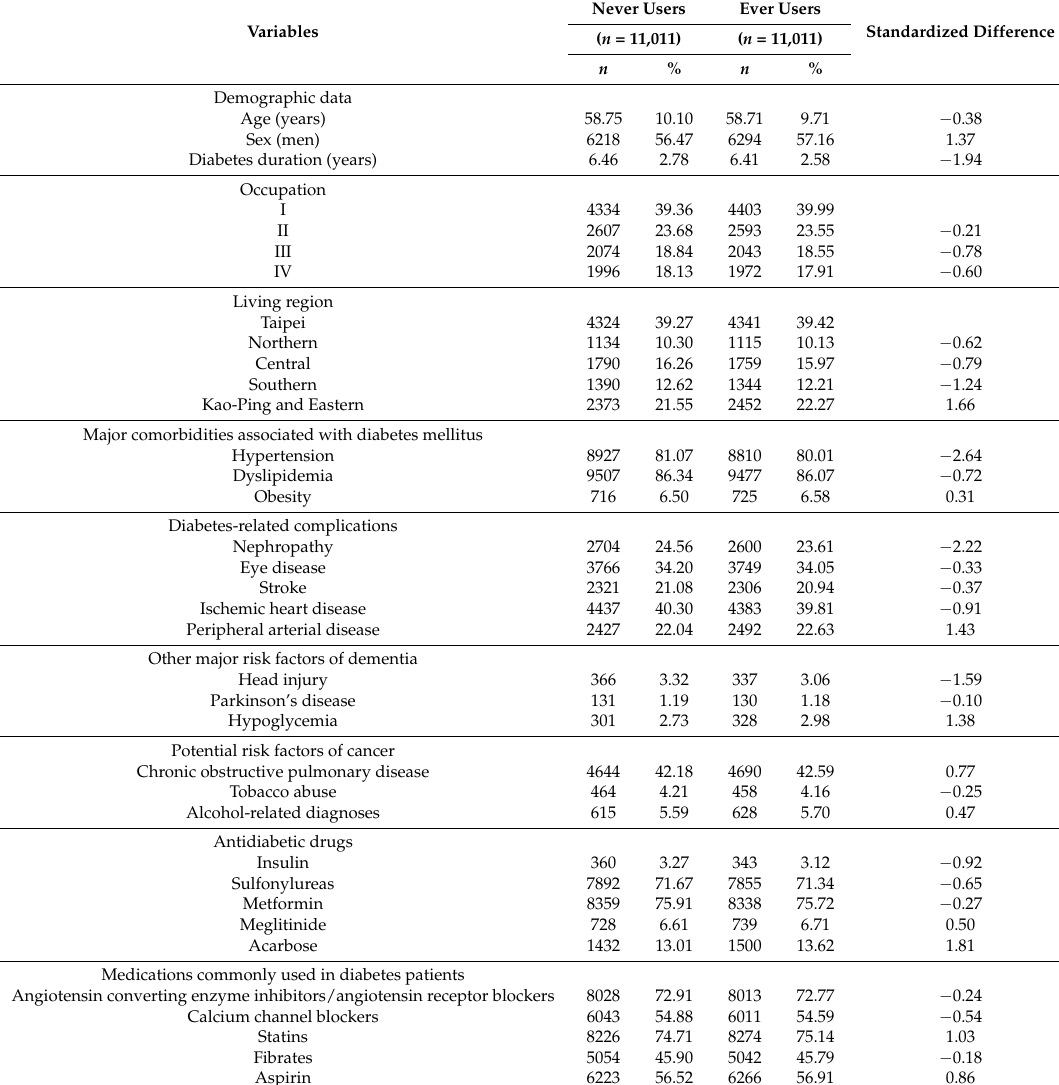
Age and diabetes duration are shown in mean and standard